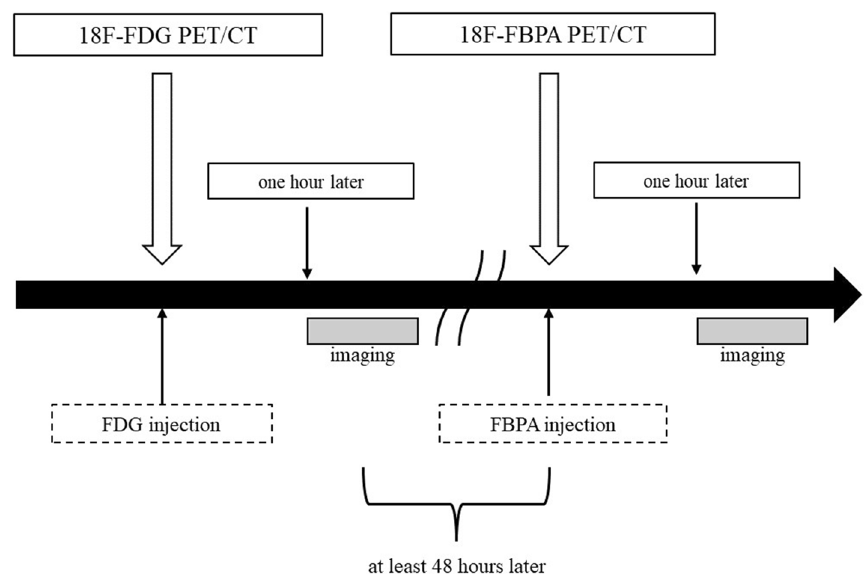
Fig. 1 The schedule of 18 F-FDG PET/CT and 18 F-BPA PET/CT